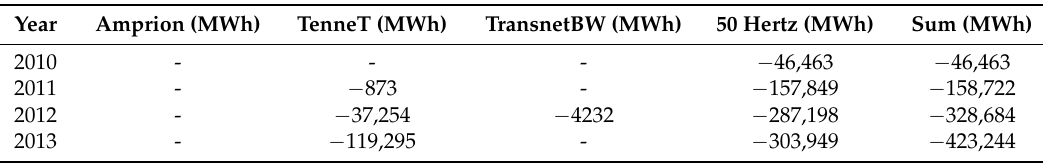
Table 1. Sum of the negative vertical grid load.